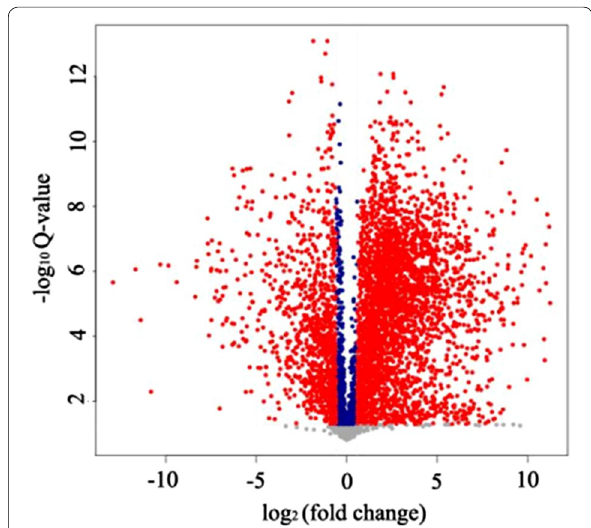
Fig. 2 Volcano plot between vanilla pods and vanilla beans [vari- ables in red are significant (Q < 0.05), and variables in blue are not significant]